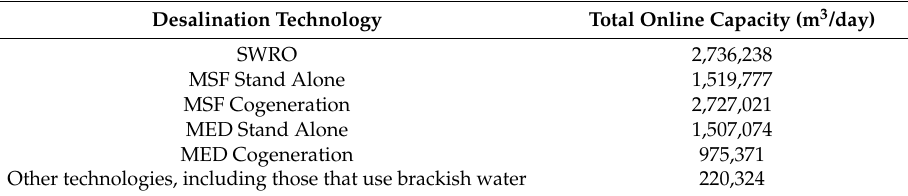
Table 7 represents the total online capacities of seawater desalination in Saudi Arabia by 2015 [47]. Table 7. Online capacities of seawater desalination in Saudi Arabia by 2015.